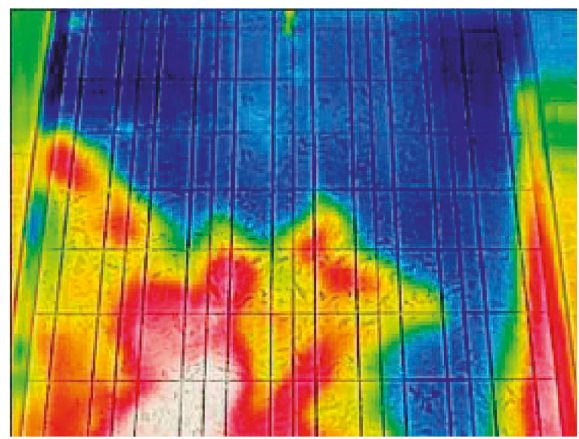
Figure 1: Thermal image of a solar panel with fault.